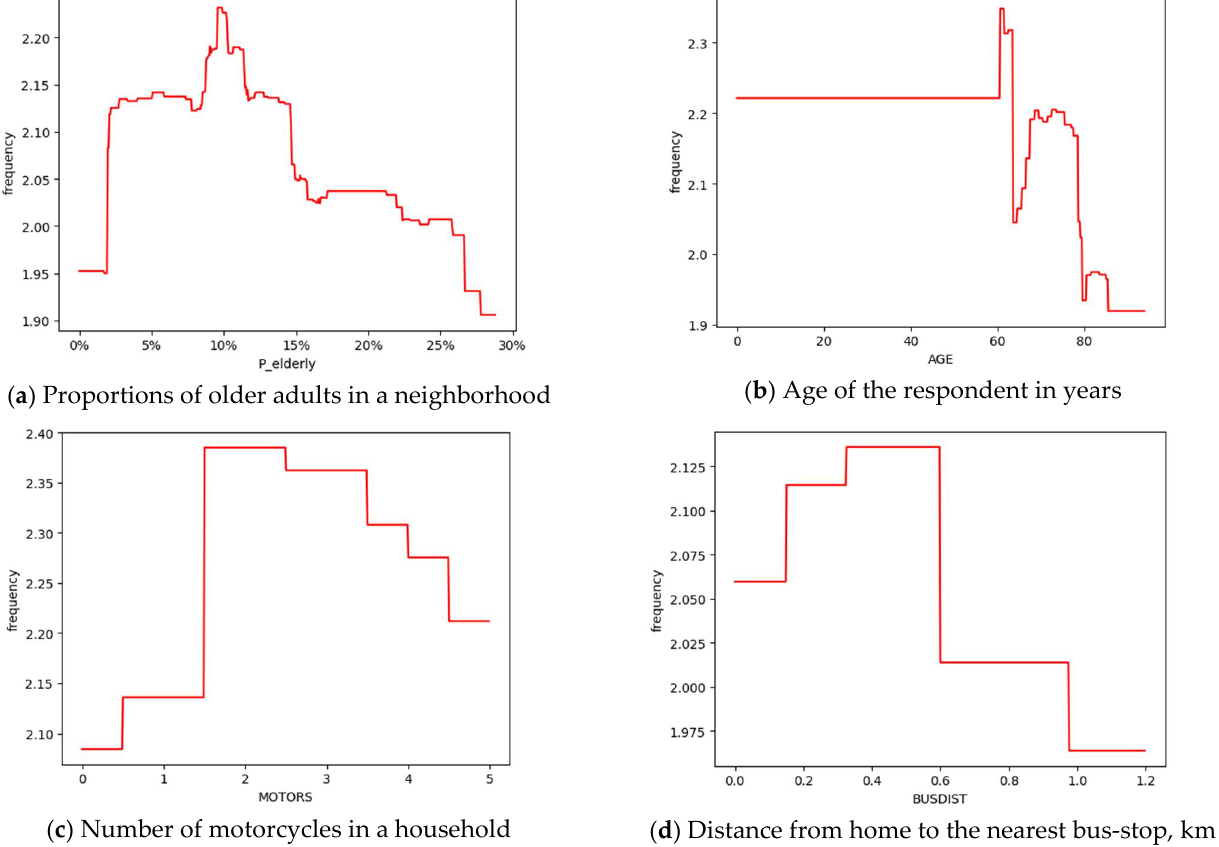
Figure 6. Associations between other key variables and bus trip frequency among older adults in Zhongshan.